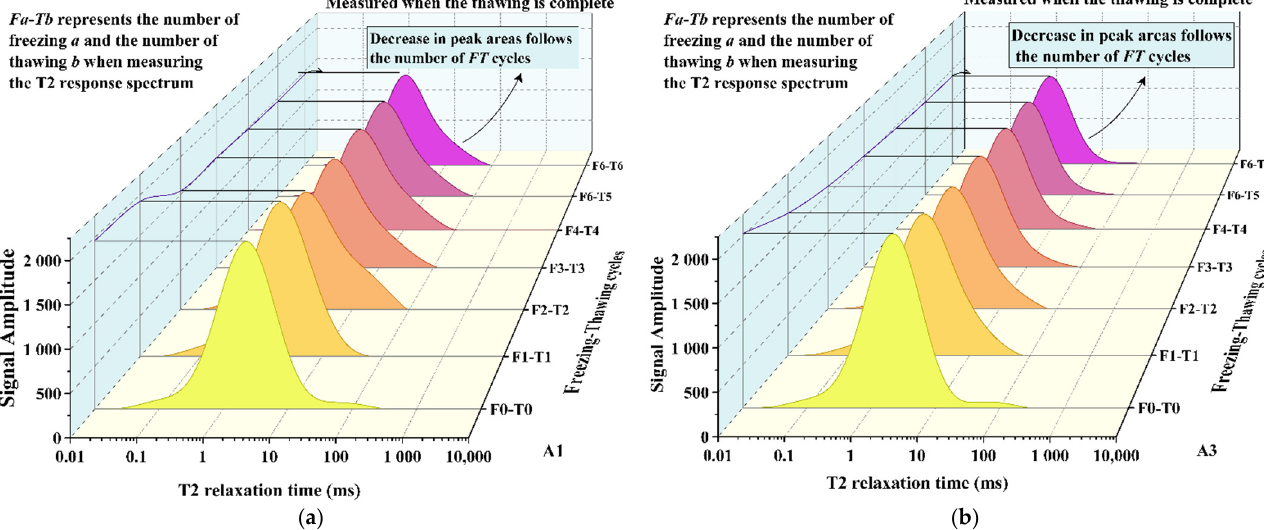
Figure 7. T2 distribution of the expansive soil after six freeze–thaw cycles. ( a ) A1 sample test results; ( b ) A3 sample test results.